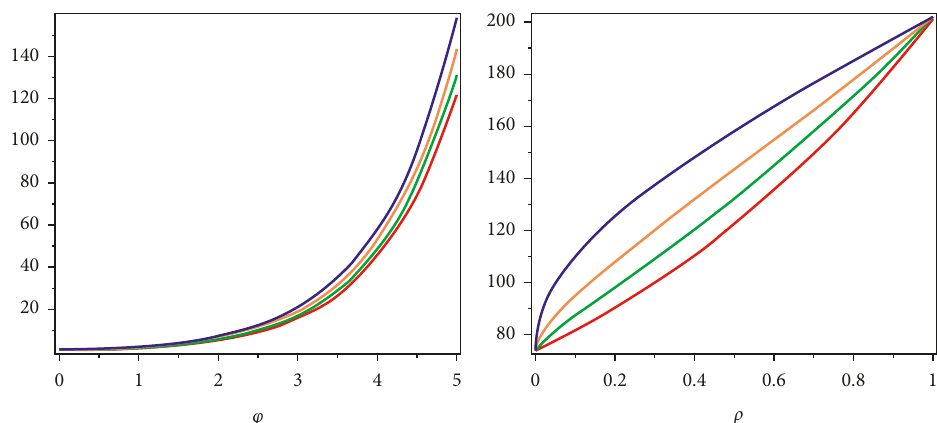
Figure 8: The graph of the two dimensions of different fractional orders at δ with respect to φ and ρ